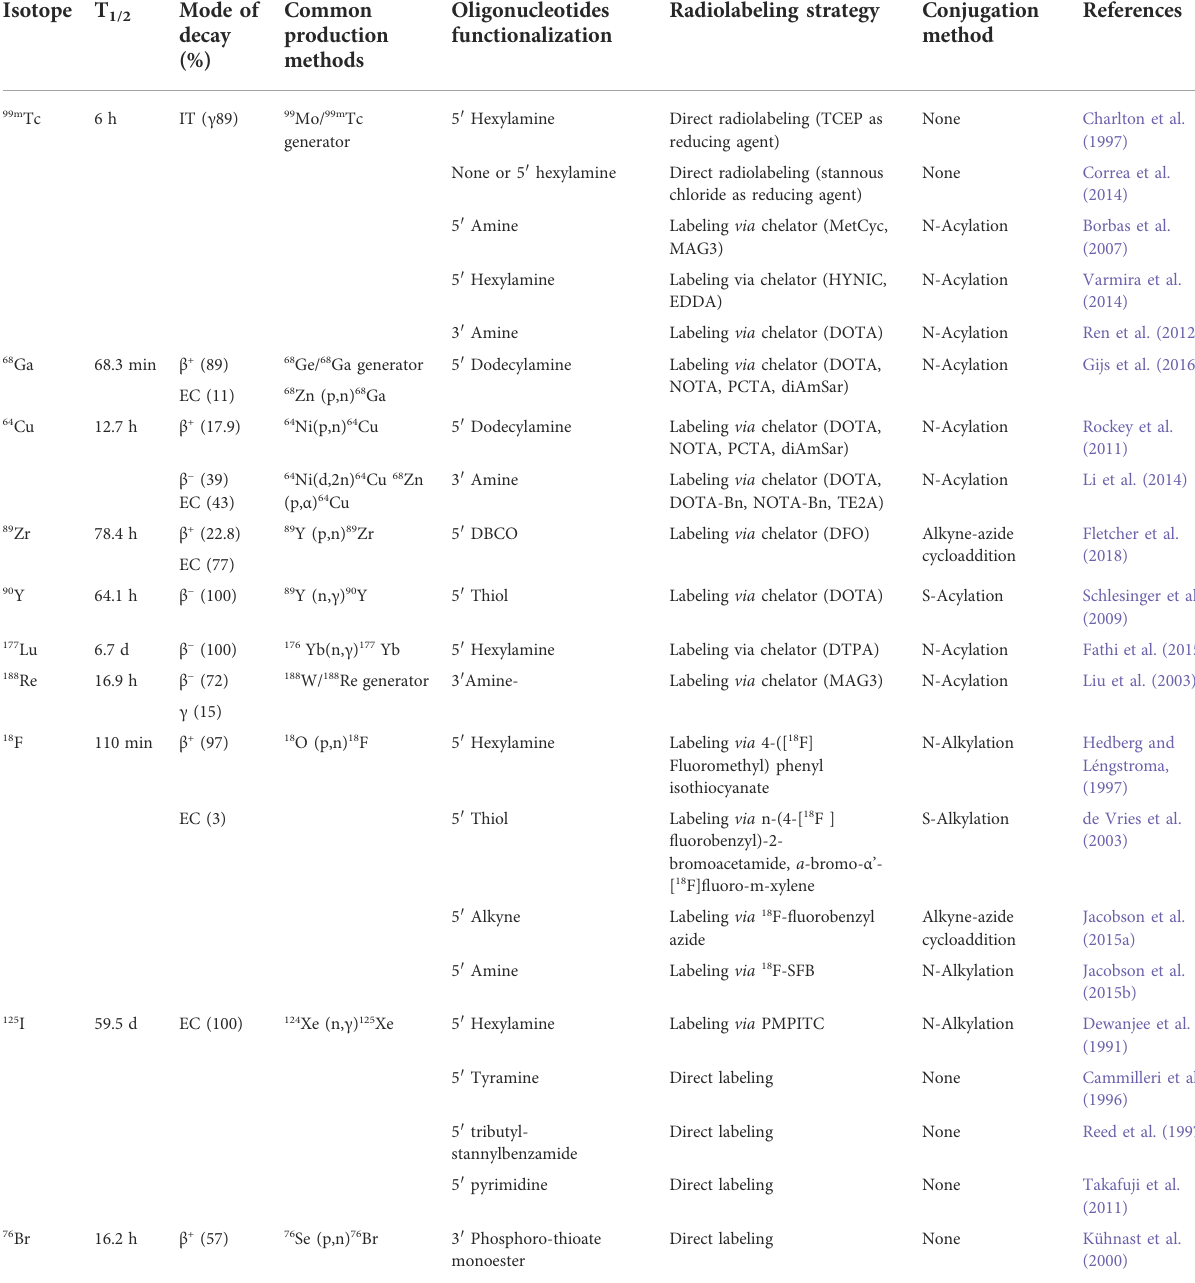
TABLE 1 Characteristics of common nuclear medicine radionuclides and current methods of radiolabeling radioisotope to